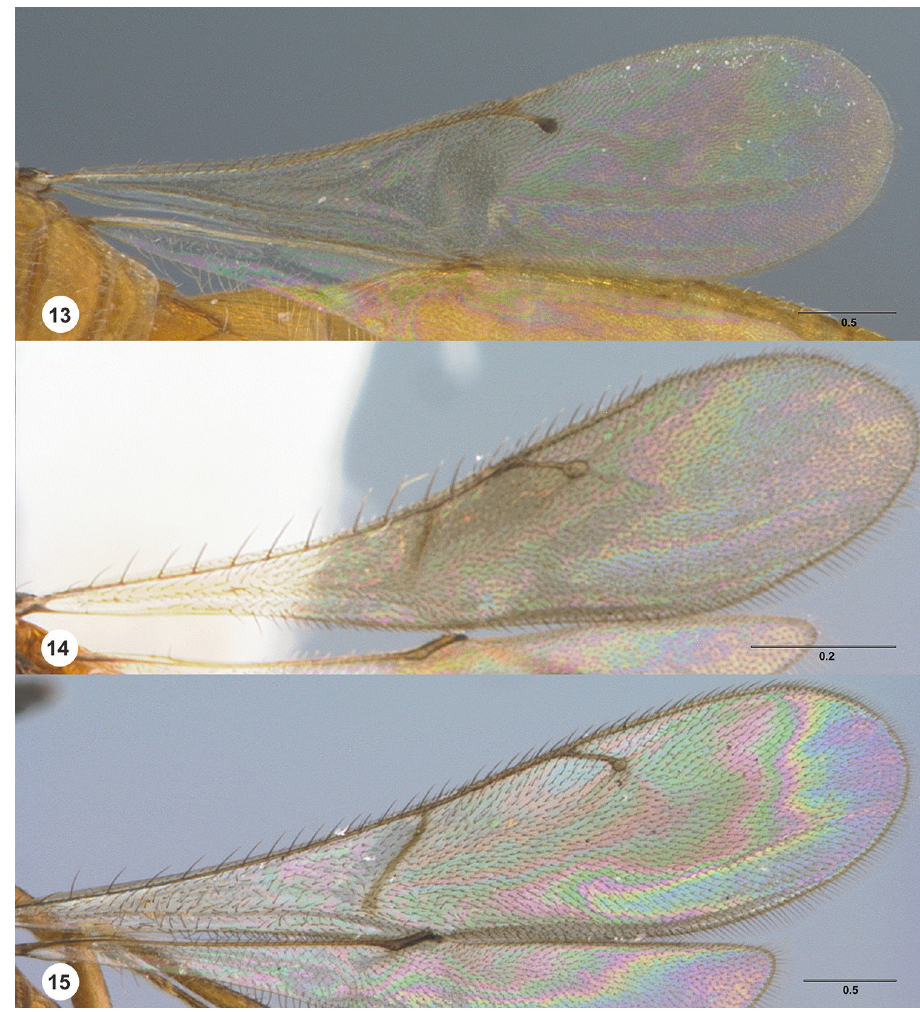
Figures 13–15. Fore wing, dorsal view 13 Calliscelio gatineau sp. n., female, holotype (OSUC 534340) 14 Calliscelio storea sp. n., female, holotype (OSUC 546117) 15 Calliscelio laticinctus Ashmead, female (OSUC 458242). Scale bars in millimeters. Color of fore wing: hyaline. Rs+M: nebulose, weakly pigmented. Setae on R: long, erect, surpassing the margin of the wing. Length of R: approximately as long as r-rs. Length of R1: approximately as long as 2.0× length of r-rs. Color of metasoma in female: yellow to dark brown. Color of metasoma in male: T3 yellow, otherwise brown to dark brown. Horn on T1 in female: large and distinct. Sculpture of T1 horn dorsally: densely and transversely striate. Sculpture of posterior margin of T1 in female: longitudinally striate throughout. Sculpture of T1 in